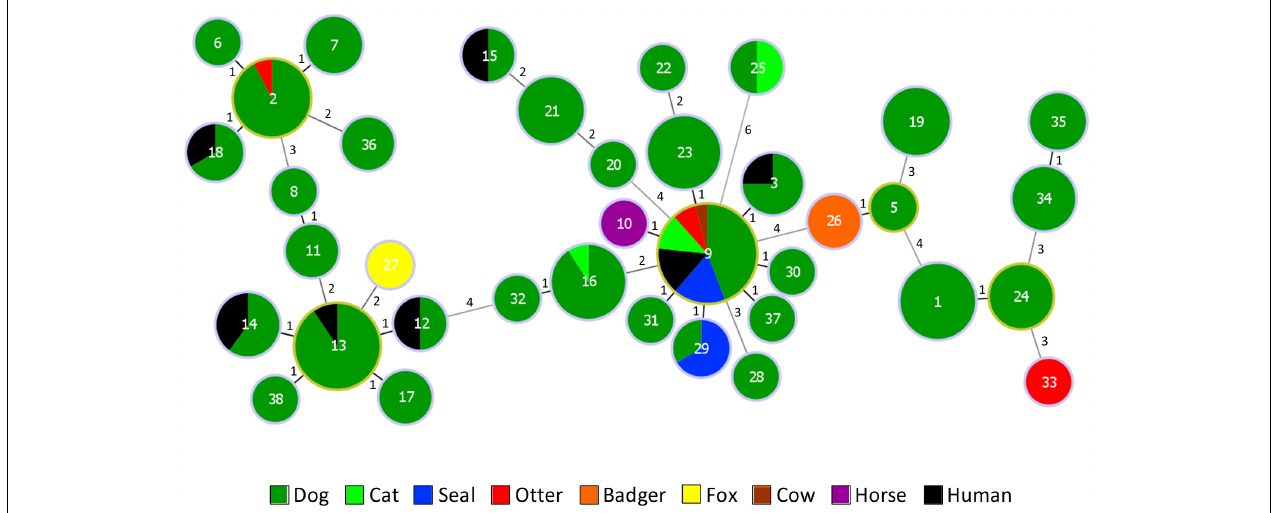
FIGURE 1 | goeBURST diagram of S. canis isolates recovered from animal and human infections. The diagram includes the 188 isolates studied plus the 3 S. canis isolates with publicly available genomes (from which MLST data was extracted). Numbers inside the circles identify the ST and numbers near the lines indicate the number of alleles different between the two connected STs. The size of each circle is proportional to the number of isolates in a logarithmic scale. The number of isolates with the same characteristic is proportional to the respective color. Putative CC founders are identified by an outer light green circle and correspond to the STs with the higher number of